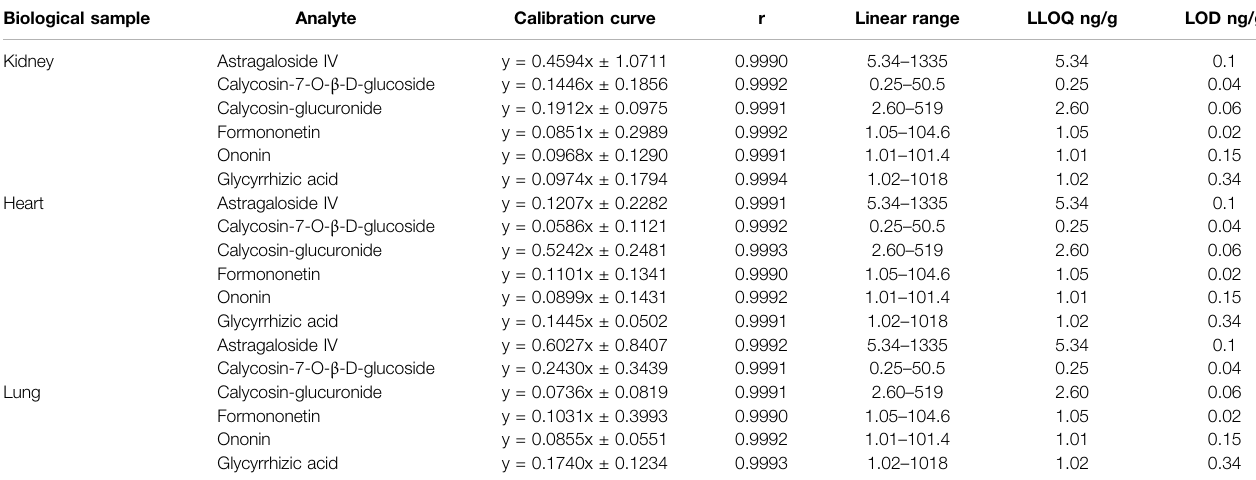
TABLE 2 | Calibration curve and LOQ of six ingredients in tissue homogenate samples. Biological sample